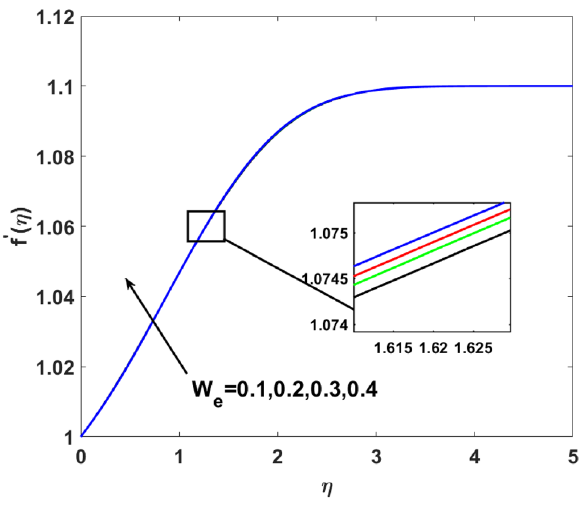
Figure 4. f ′ (η) versus W e .